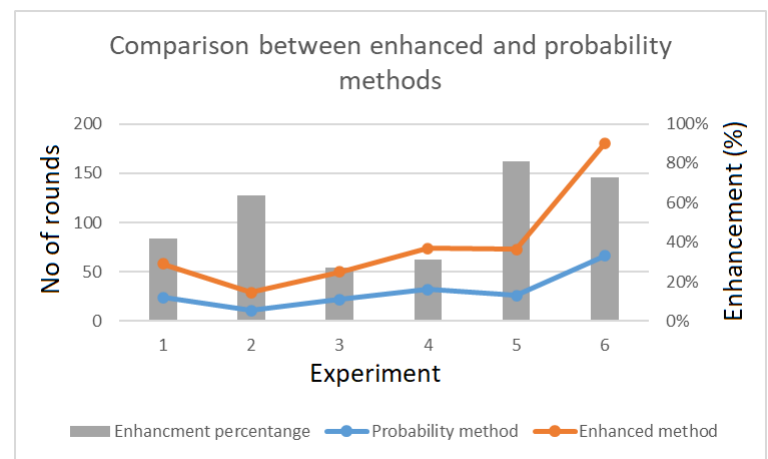
Figure 33. Percentage improvement between the enhanced selection of k provides in comparison with probability method.